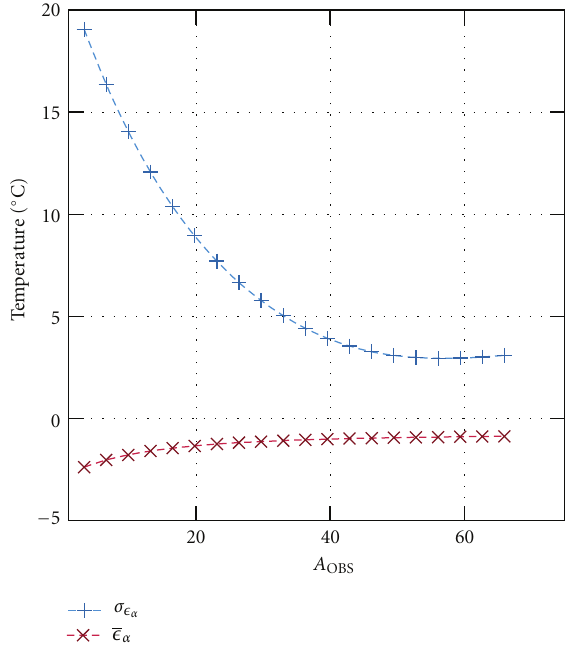
Figure 3: Average and standard deviation of the error in fluid tem- perature as the magnitude of the obstruction mixing coe ffi cient is